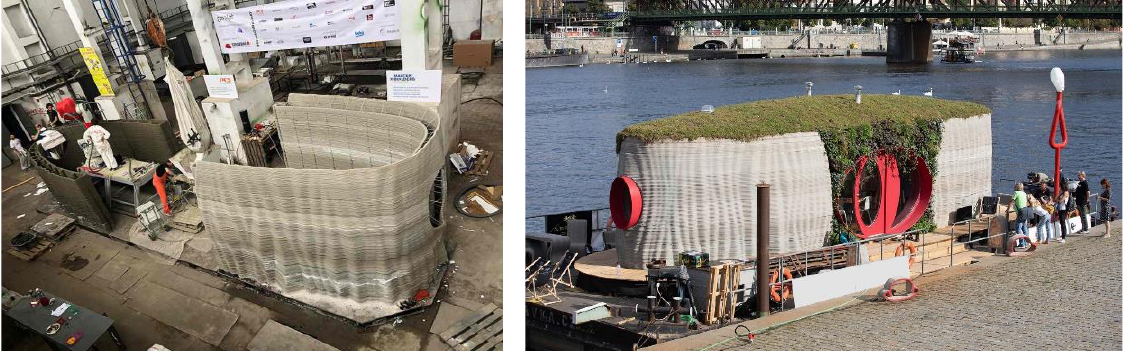
Figure 7: The world's first 3D-printed floating house (Czech Republic)